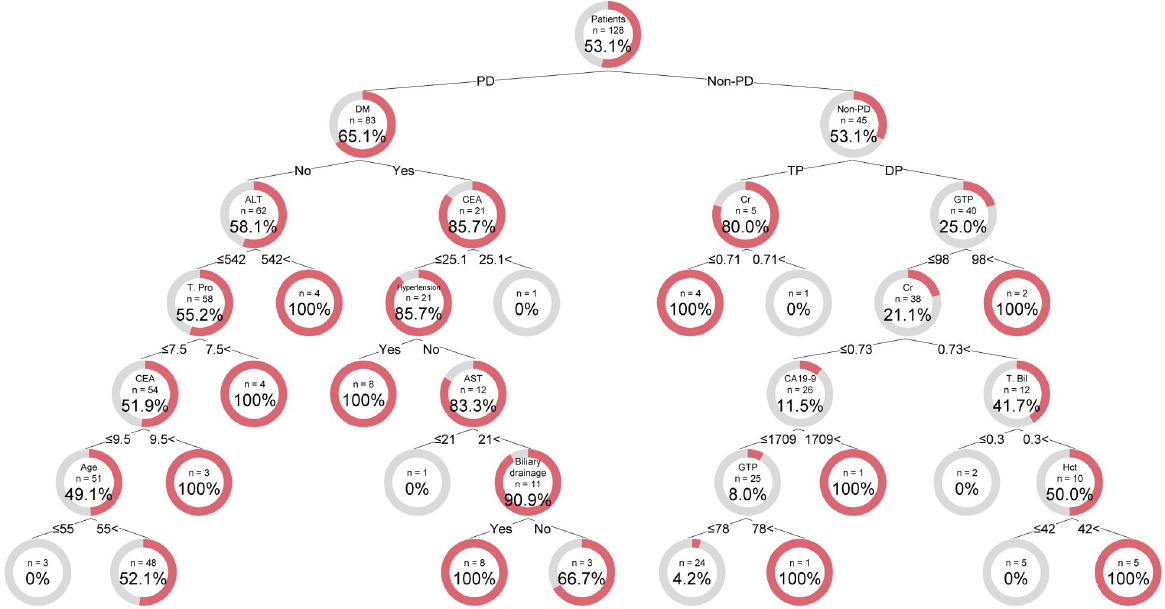
Fig 2. Illustration of the decision tree model for massive IBL occurrence. The sample number and factors for splitting are indicated for each node. The doughnut chart shows the percentage of patients with massive IBL (red) and without massive IBL (gray) in each node. Links between nodes indicate the cutoff value for the split or Yes/No. A high number within terminal nodes indicates that the tree would classify patients as likely to experience massive IBL. A low number in terminal nodes indicates non-massive IBL. ALT, alanine aminotransferase (U/L); AST, aspartate aminotransferase (U/L); CA19-9, carbohydrate antigen 19–9 (U/mL); CEA, carcinoembryonic antigen (ng/mL); DM, diabetes mellitus; DP, distal pancreatectomy; GTP, glutamyl transpeptidase (U/L); HCT, hematocrit (%); IBL, intraoperative blood loss; PD, pancreaticoduodenectomy; T. Bil, total bilirubin (mg/dL); TP, total pancreatectomy; T. Pro, total protein (g/dL).